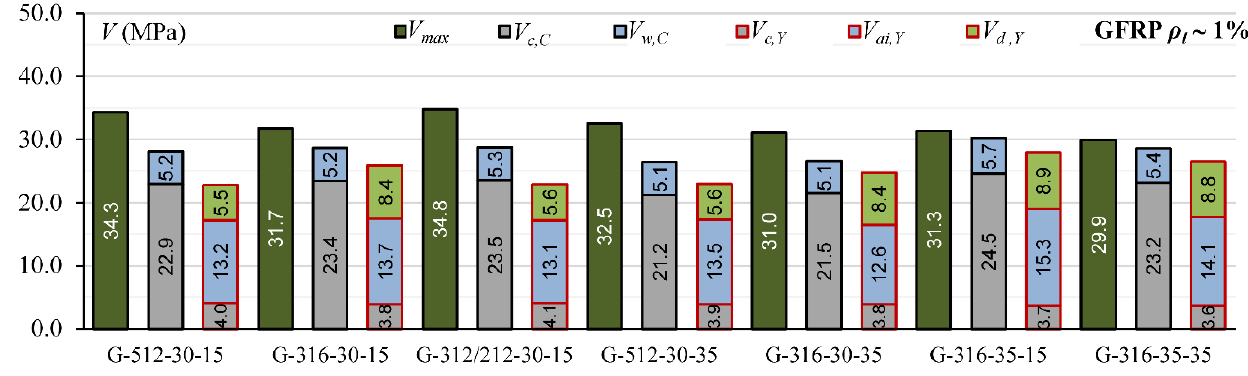
Figure 8. The comparison of shear mechanism contribution for GFRP-reinforced beams with rein- forcement ratio ρ l ~ 1% for Cladera et al.’s and Yang’s models.